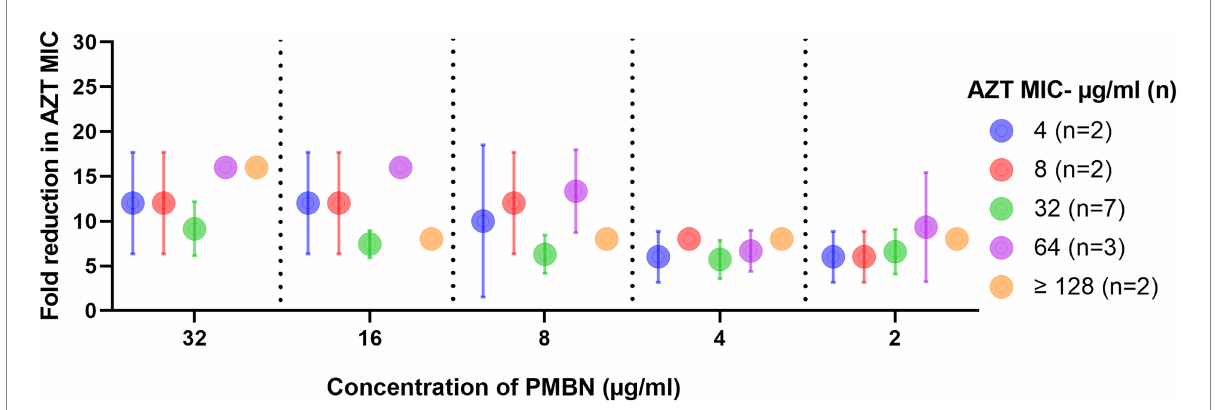
FIGURE 1 Fold reduction in AZT MIC when used in combination with different concentrations of PMBN. Data shown represent mean ± SD of fold reduction in MICs for tested strains treated with the synergistic combinations. Baseline AZT MICs (when used alone) for the strains are shown in the figure legend. Only strains ( n = 16) against which the combinations were synergistic are